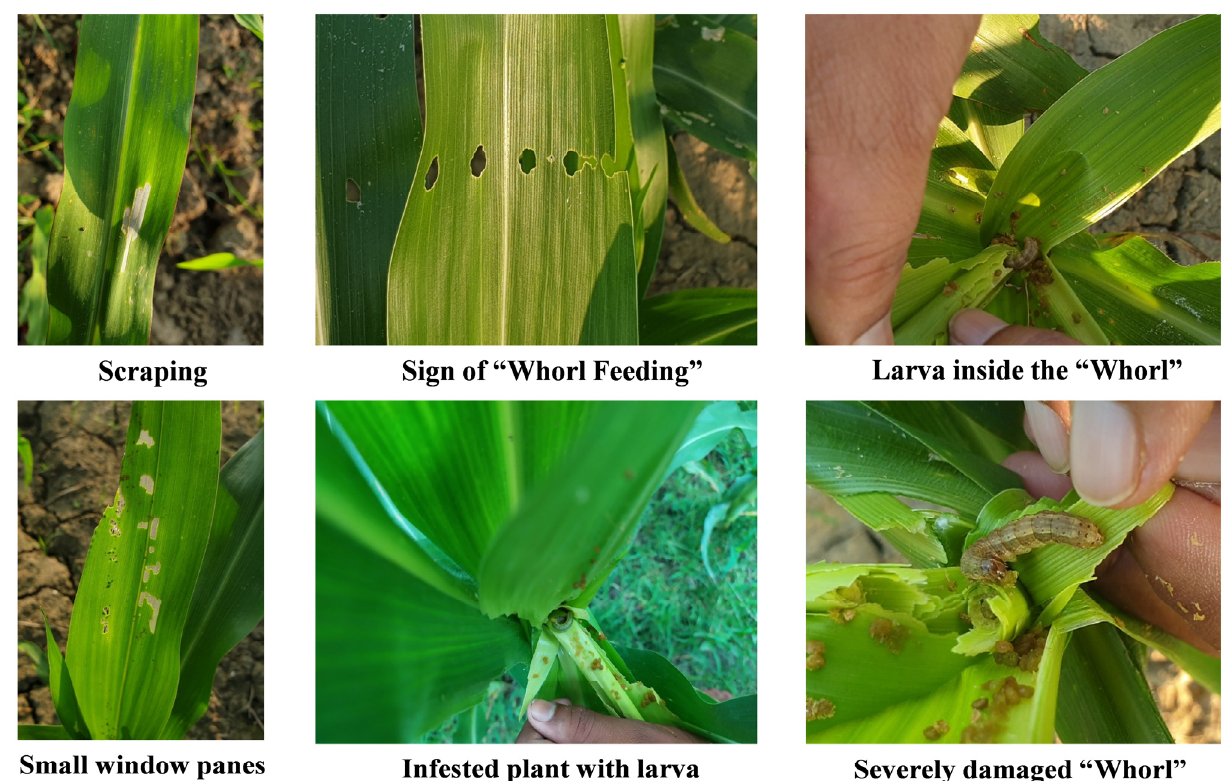
Figure 2. Different damage symptoms in maize caused by fall armyworm larvae.